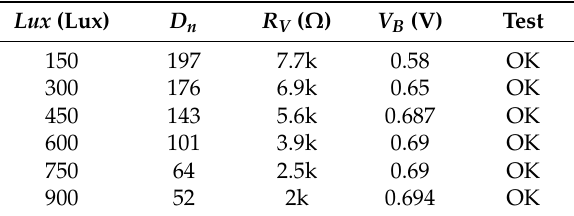
Table 4. Experimental results of 𝑅 𝑉 , 𝐷 𝑛 and Lux .